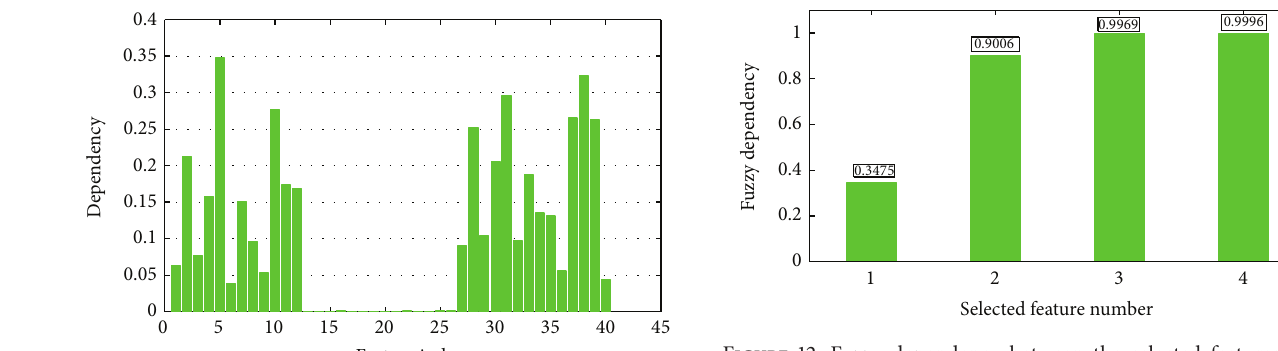
Figure 12: Fuzzy dependency between the selected features and decisions (Features 5, 37, 2, and 3 are selected sequentially).